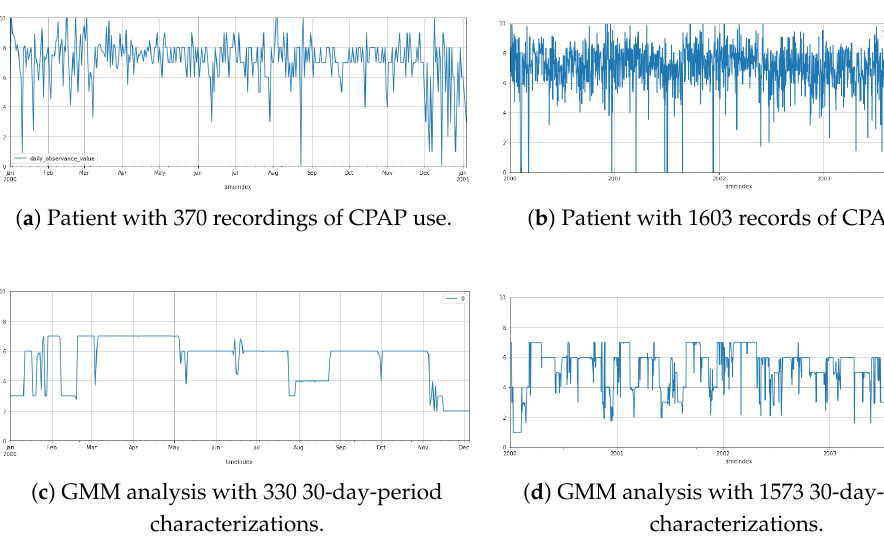
Figure 9. GMM characterization of two patients from the CPAP use dataset. The first patient in plot ( a ) and its corresponding sliding-window characterization in plot ( c ). The second patient in plot ( b ) characterized in plot ( d